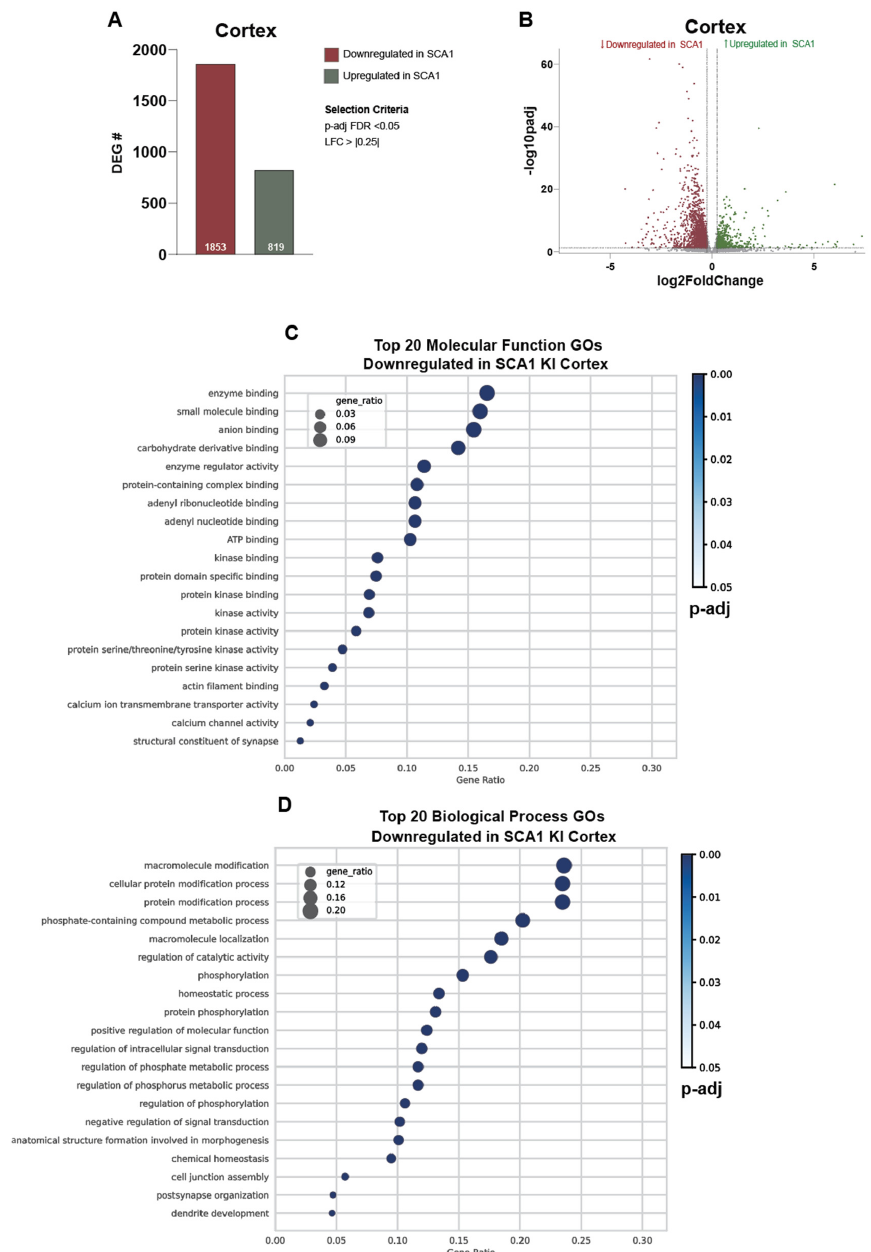
Figure 3. Transcriptomic alterations in the SCA1 KI mouse cortex at 12 weeks. ( A ), Number of up- and down-regulated DEGs in the SCA1 KI mouse cortex compared to WT littermate controls at 12 weeks. Genes with an FDR adjusted p -value < 0.05 and a log2fold change > |0.25| were considered significant. ( B ), Volcano plot of up- and down-regulated DEGs in the SCA1 KI mouse cortex, with significance cutoffs indicated. ( C , D ), Top 20 Molecular Function ( C ) and Biological Process ( D ) GO terms for down-regulated genes in the SCA1 KI mouse cortex. Top 20 GO terms are plotted by gene ratio, with circle color indicating adjusted p -value, and circle circumference indicating gene-ratio, or the ratio of DEGs identified within the listed GO term.